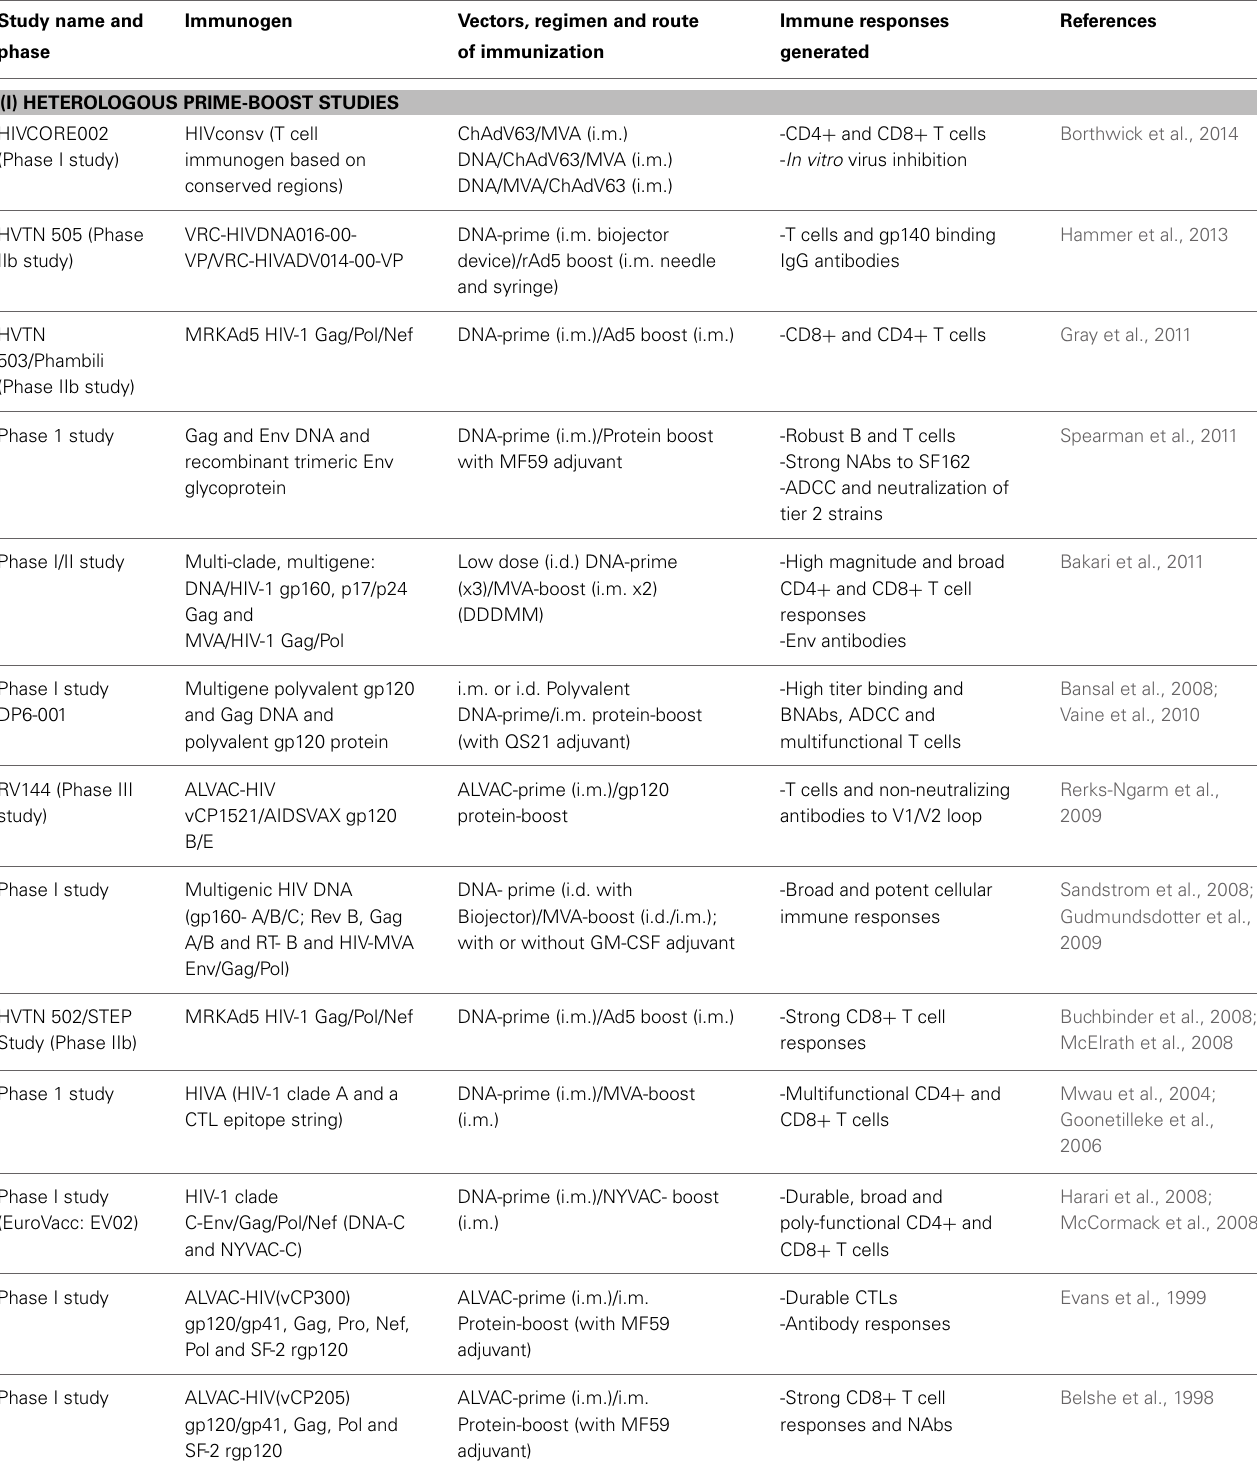
Table 1 | Representative clinical